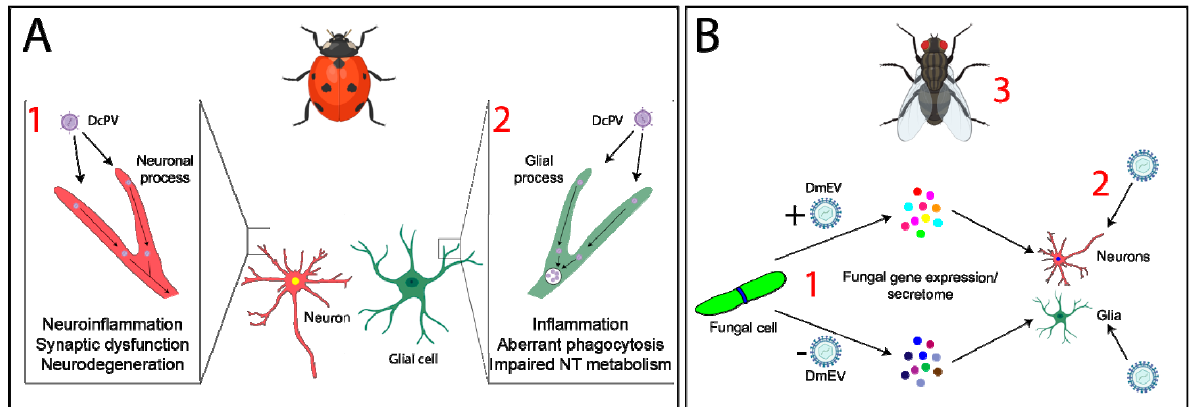
Figure 2. Parasites within parasites—potential impacts on neuroinflammation and glial cell function. ( A ) Dinocampus coccinellae paralysis virus (DcPV) is believed to trigger changes in host behavior via altering neuroinflammatory processes and glial cell function [64]. Future studies should investigate (1) if and how the virus enters neurons, mechanisms of intra-/inter-neuronal transport, effects on host neuronal gene and/or protein expression, and potential alterations in neuroinflammatory responses. These data would help provide insight into mechanisms of neuroinflammation, synaptic dysfunction, and/or neurodegeneration that may elicit changes in behavior. (2) Investigation into how glial cells respond to DcPV infection will provide data critical to understanding whether glial cells mediate neuron damage, AMP release, changes in neurotransmitter (NT) metabolism, or phagocytosis of neuronal debris in this system. ( B ) Entomophthovirus (DmEV) is associated with the entomopathogenic fungus E. muscae , but whether viral infection of the fungus contributes to host behavioral change remains unclear. (1) Future research should investigate whether fungal gene expression or the fungal secretome differs following DmEV infection. Additionally, whether the virus can be transferred from the fungus to host tissue (e.g., neurons or glia) causing direct effects remains to be determined (2). It is also possible that host immune responses to fungal infection may differ (3), similar to what is seen in infection with Leishmania parasites [111]. Images created with BioRender.com (accessed on 15 January 2021).